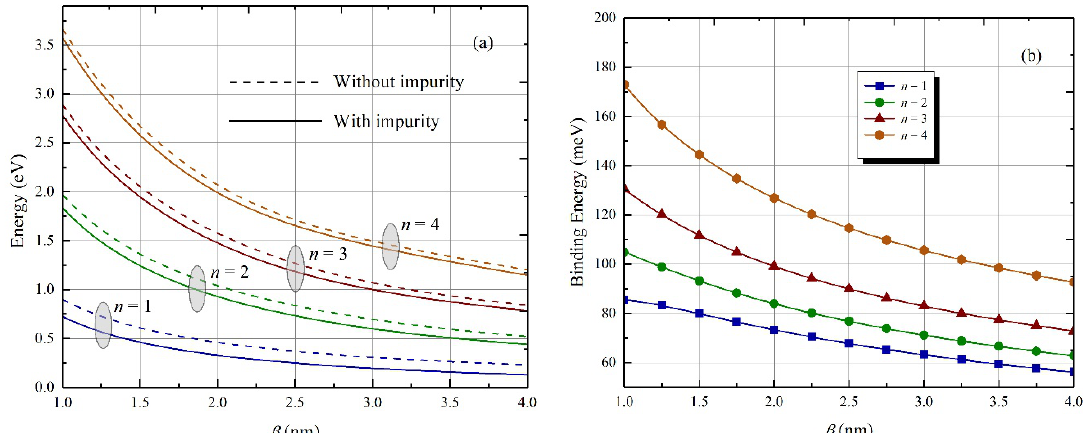
Figure 2. Dependence of the first four energy levels on the half-width β with and without the impurity center ( a ), and binding energy ( b ) on the half-width β for the same levels.